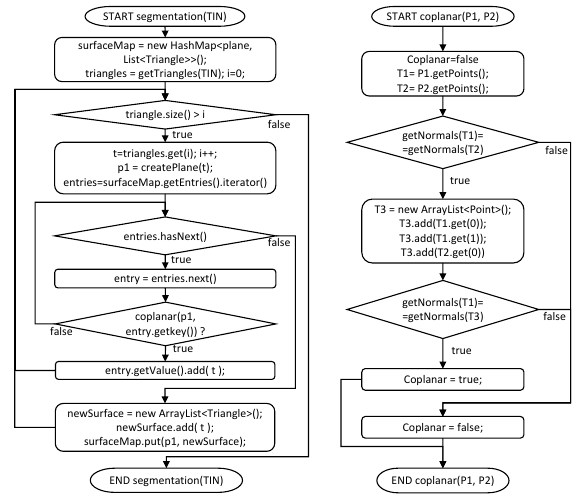
Figure 10. Segmentation of TIN into surface